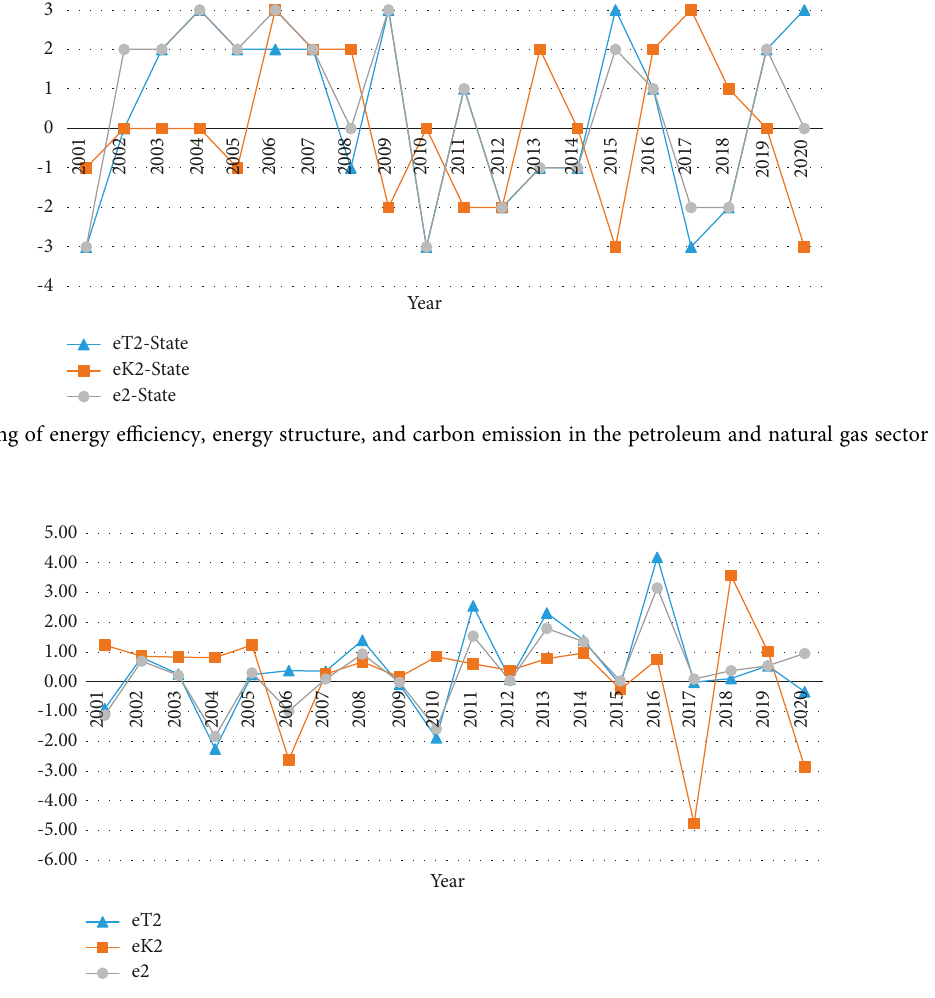
Figure 13: Relationship between carbon emission decoupling index and intermediate variables of the petroleum and natural gas sector from 2001 to